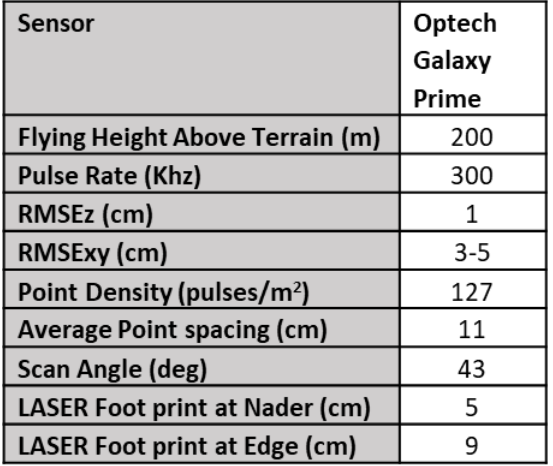
Table 1. High precision aerial LiDAR campaign parameters used as reference surface.